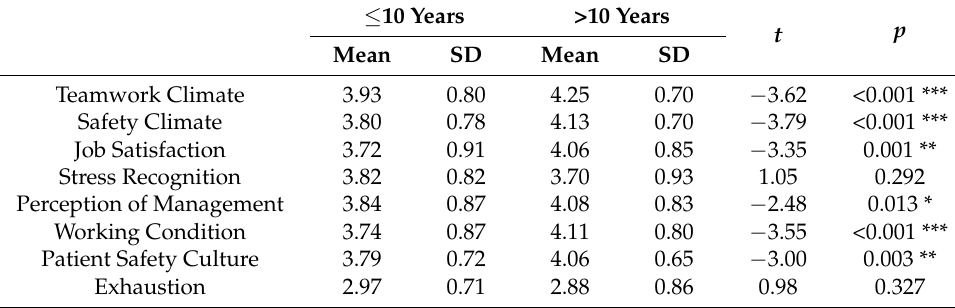
Table 6. Differences between means by